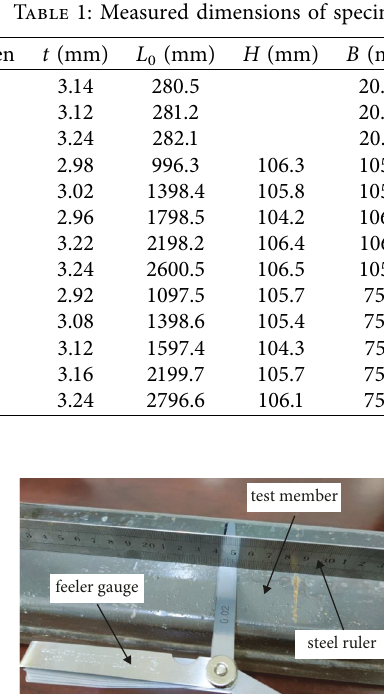
Figure 2: Measurement method of the initial geometric imper- fection of specimens.